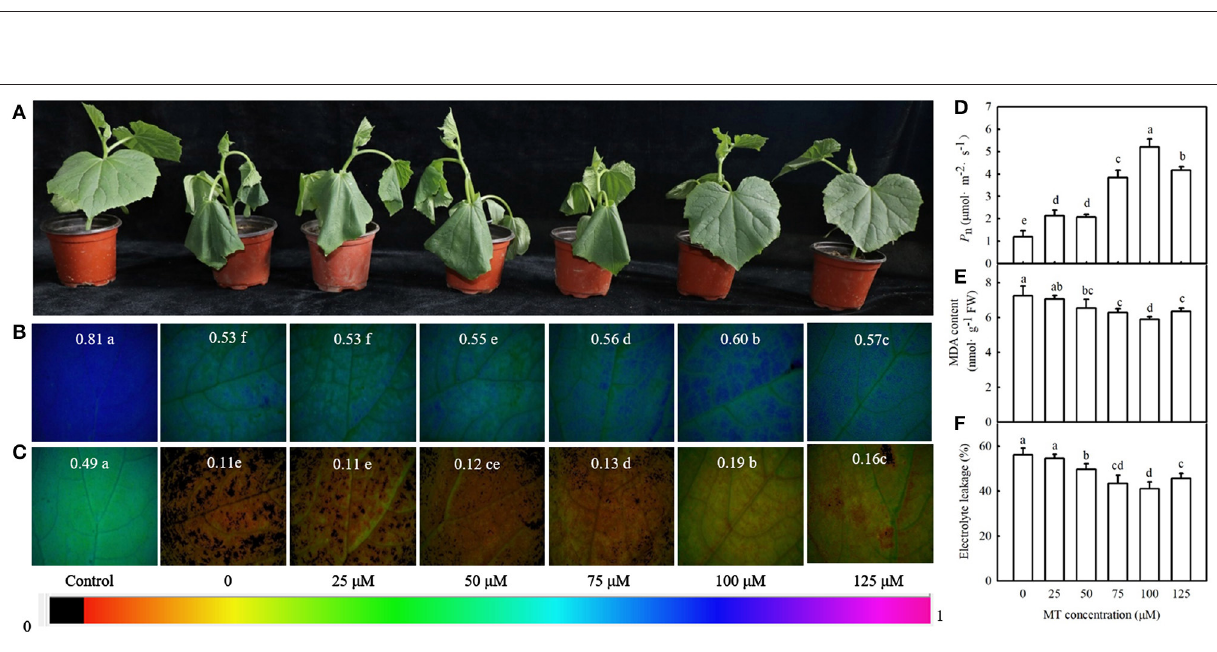
Frontiers in Plant Science |